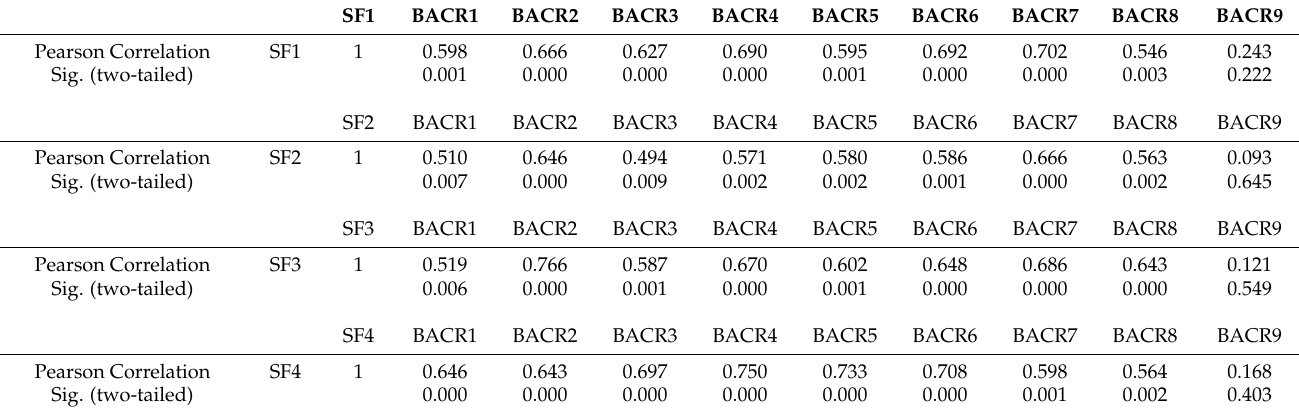
Table 3. Correlation analysis between SFDRR and resilient buildings and communities.